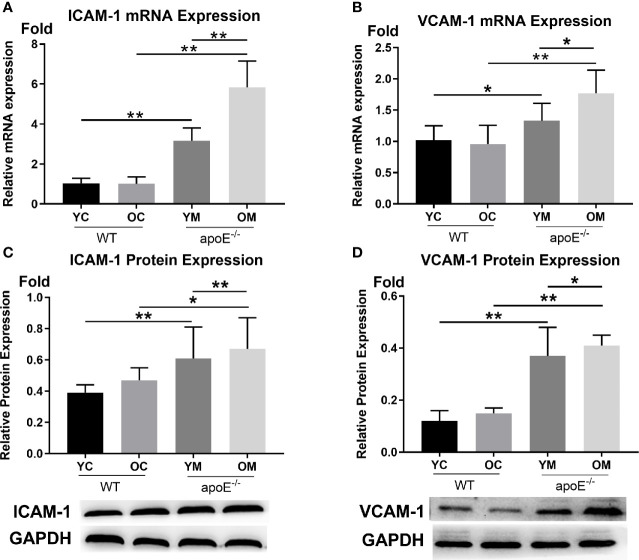
Transcription levels and expression levels of ICAM-1 and VCAM-1 in the aortas, n=6 mice per group. (A, B) Quantification of ICAM-1 and VCAM-1 transcription; (C, D) Quantification of ICAM-1 and VCAM-1 protein expressions. Data were shown as mean ± SD. *
p <0.05; **
p <0.01. p values are calculated from T-test.